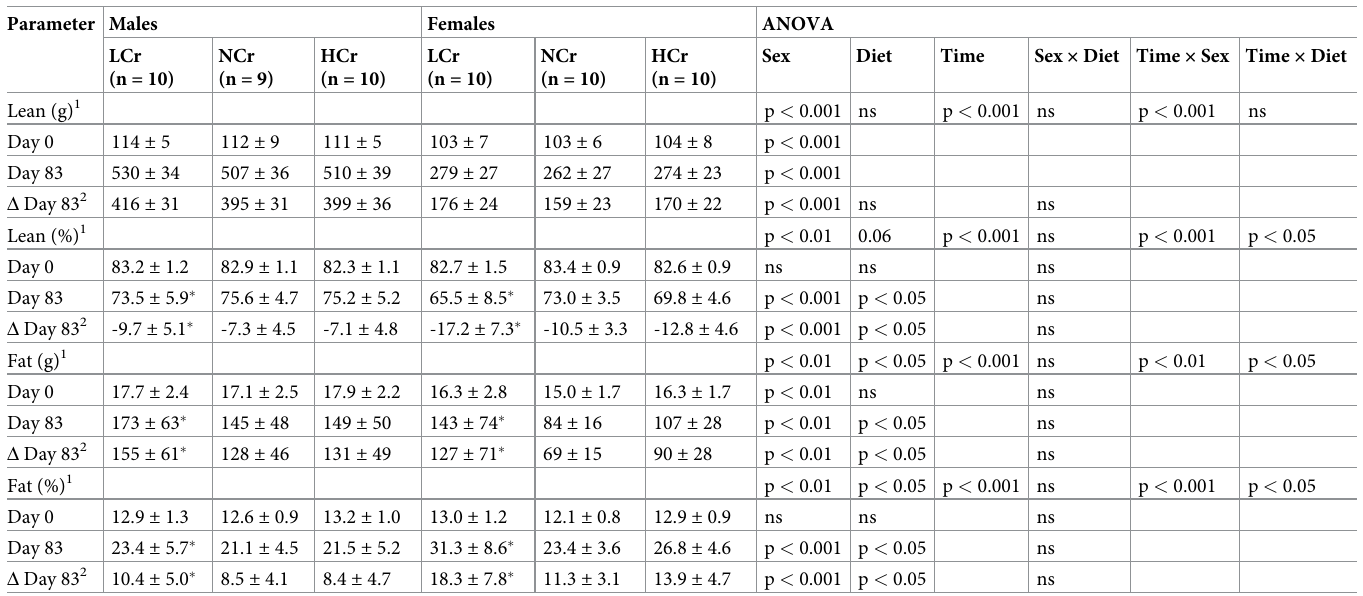
Table 1. Body composition of rats.